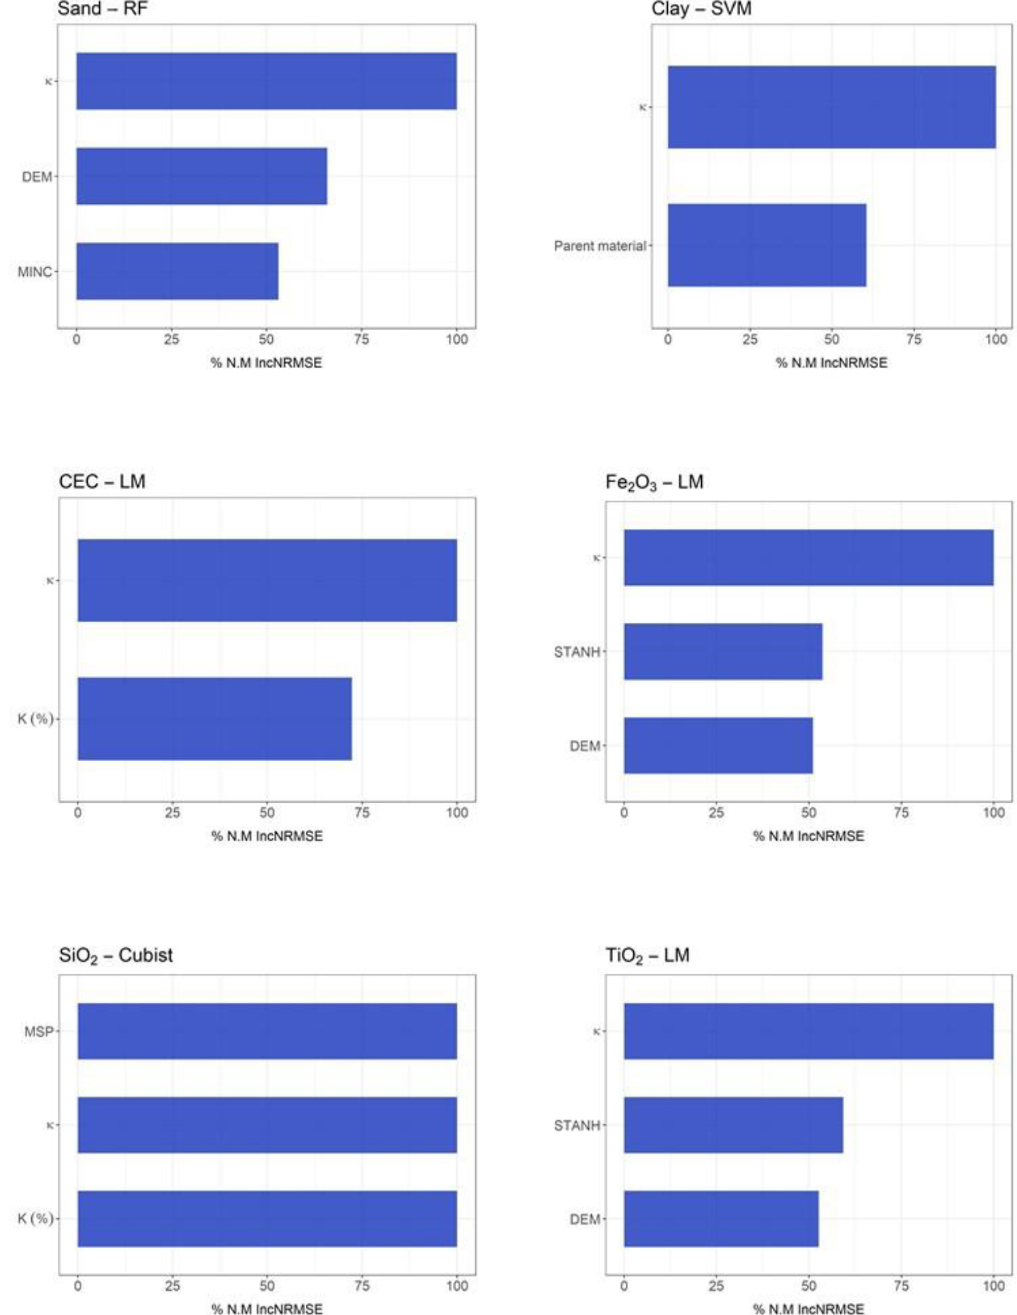
Figure 8. Variable importance for gamma-ray spectrometer + susceptibilimeter sensors (only variables that contributed more than 50% are presented here; for further details see